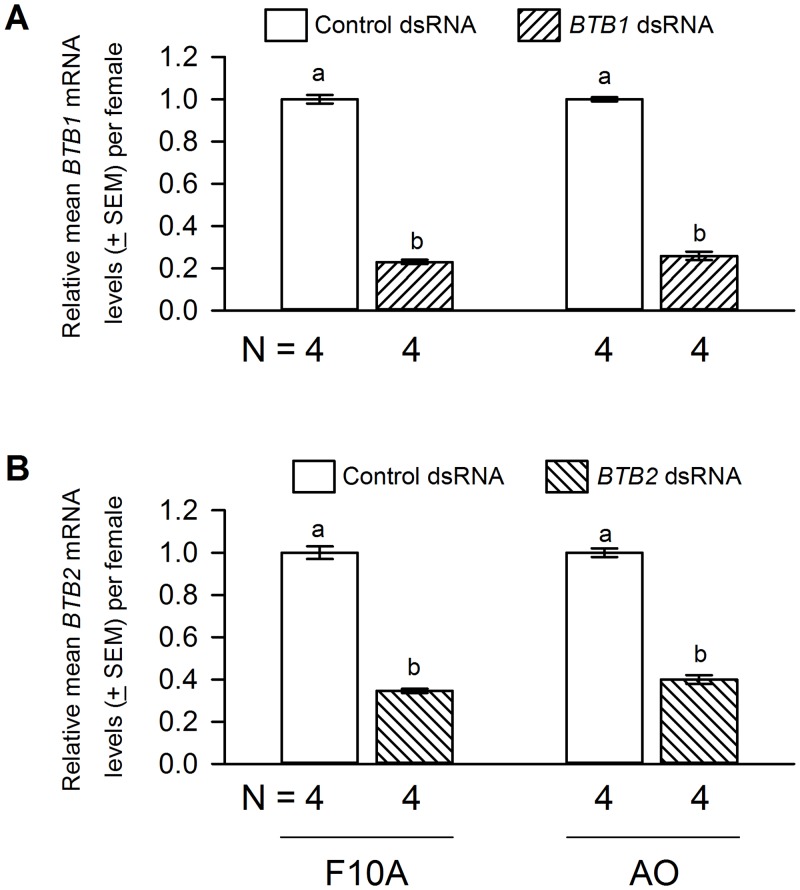
The effects of BTB1 and BTB2 dsRNA deliveries on the mRNA levels of BTB1 and BTB2, respectively.
BTB1
(A) and BTB2
(B) dsRNA deliveries resulted in significant knockdown in the mRNA levels of BTB1 and BTB2, respectively, in either F10A or AO females. Student’s t test results for the comparison of the relative BTB1 (or BTB2) mRNA levels in F10A (or AO) females that received control and BTB1 dsRNA are P < 0.000001, 2-tailed t test. The BTB1 (or BTB2) mRNA levels in control females were scaled to 1. Different letters denote significant differences.